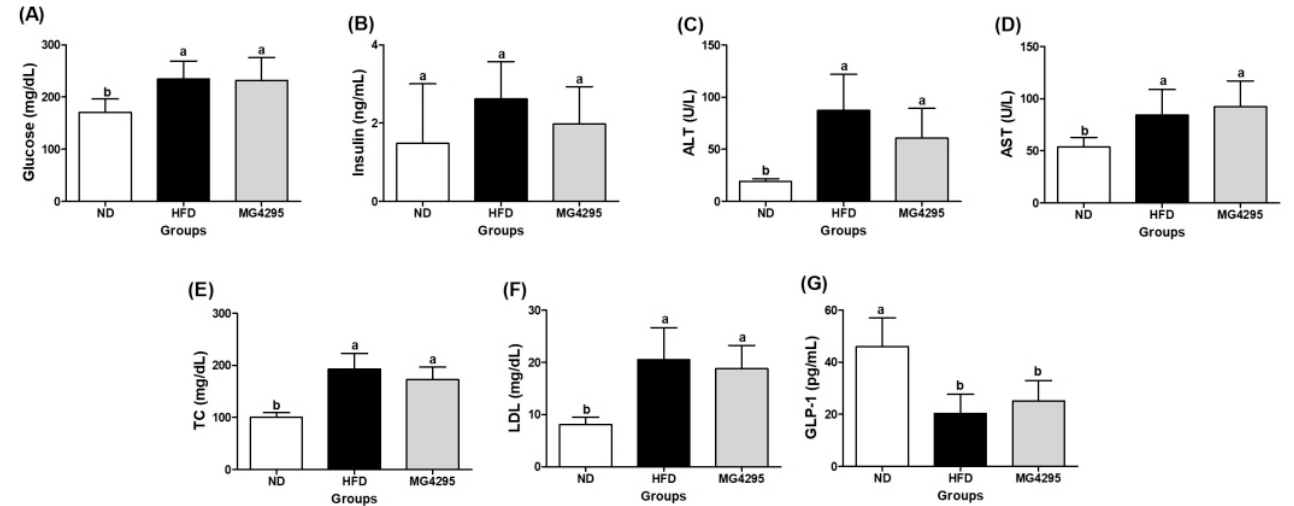
Figure 3. Effect of L. fermentum MG4295 on biochemical parameters. ( A ) Glucose, ( B ) insulin, ( C ) ALT, ( D ) AST, ( E ) TC, ( F ) LDL, and ( G ) GLP-1 in HFD-induced mice serum. The results are presented as mean ± SD ( n = 8). Different letters indicate a significant difference at p < 0.05.